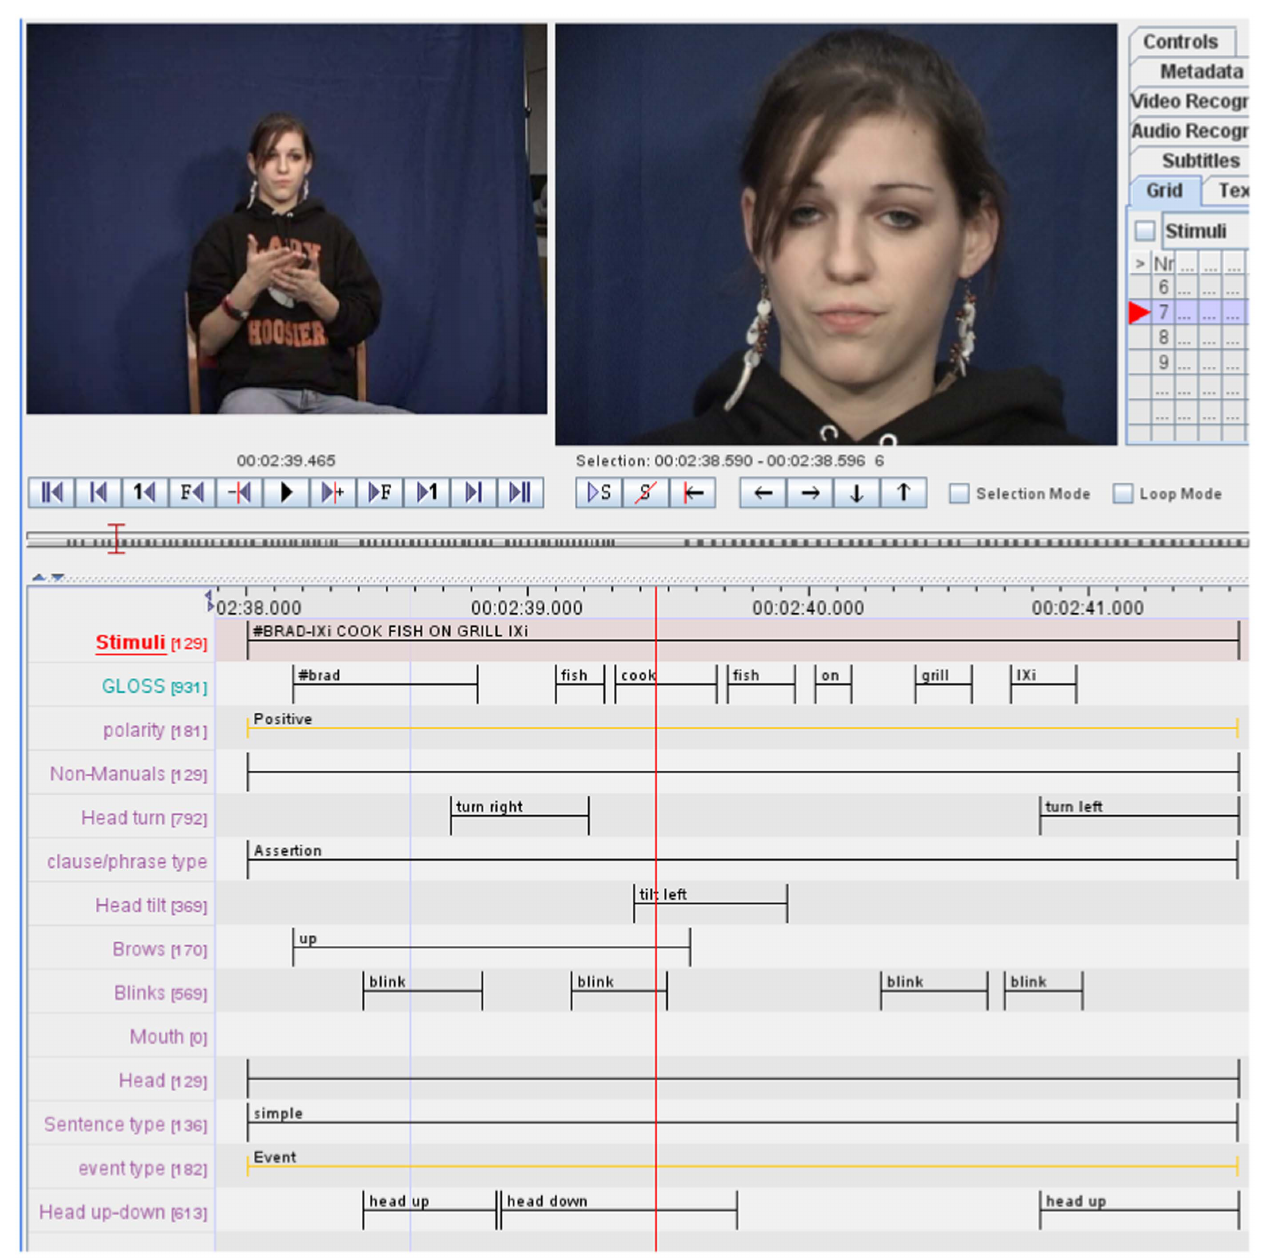
Figure 1. ELAN is a computer software that allows users to view synchronized videos simultaneously and frame by frame (top of figure), facilitating manual annotations (bottom half). Our manual annotations specify where the sentence starts and ends, where each word (or concept) starts and ends, plus the shape and configural features used to uncover the linguistic model (see text).